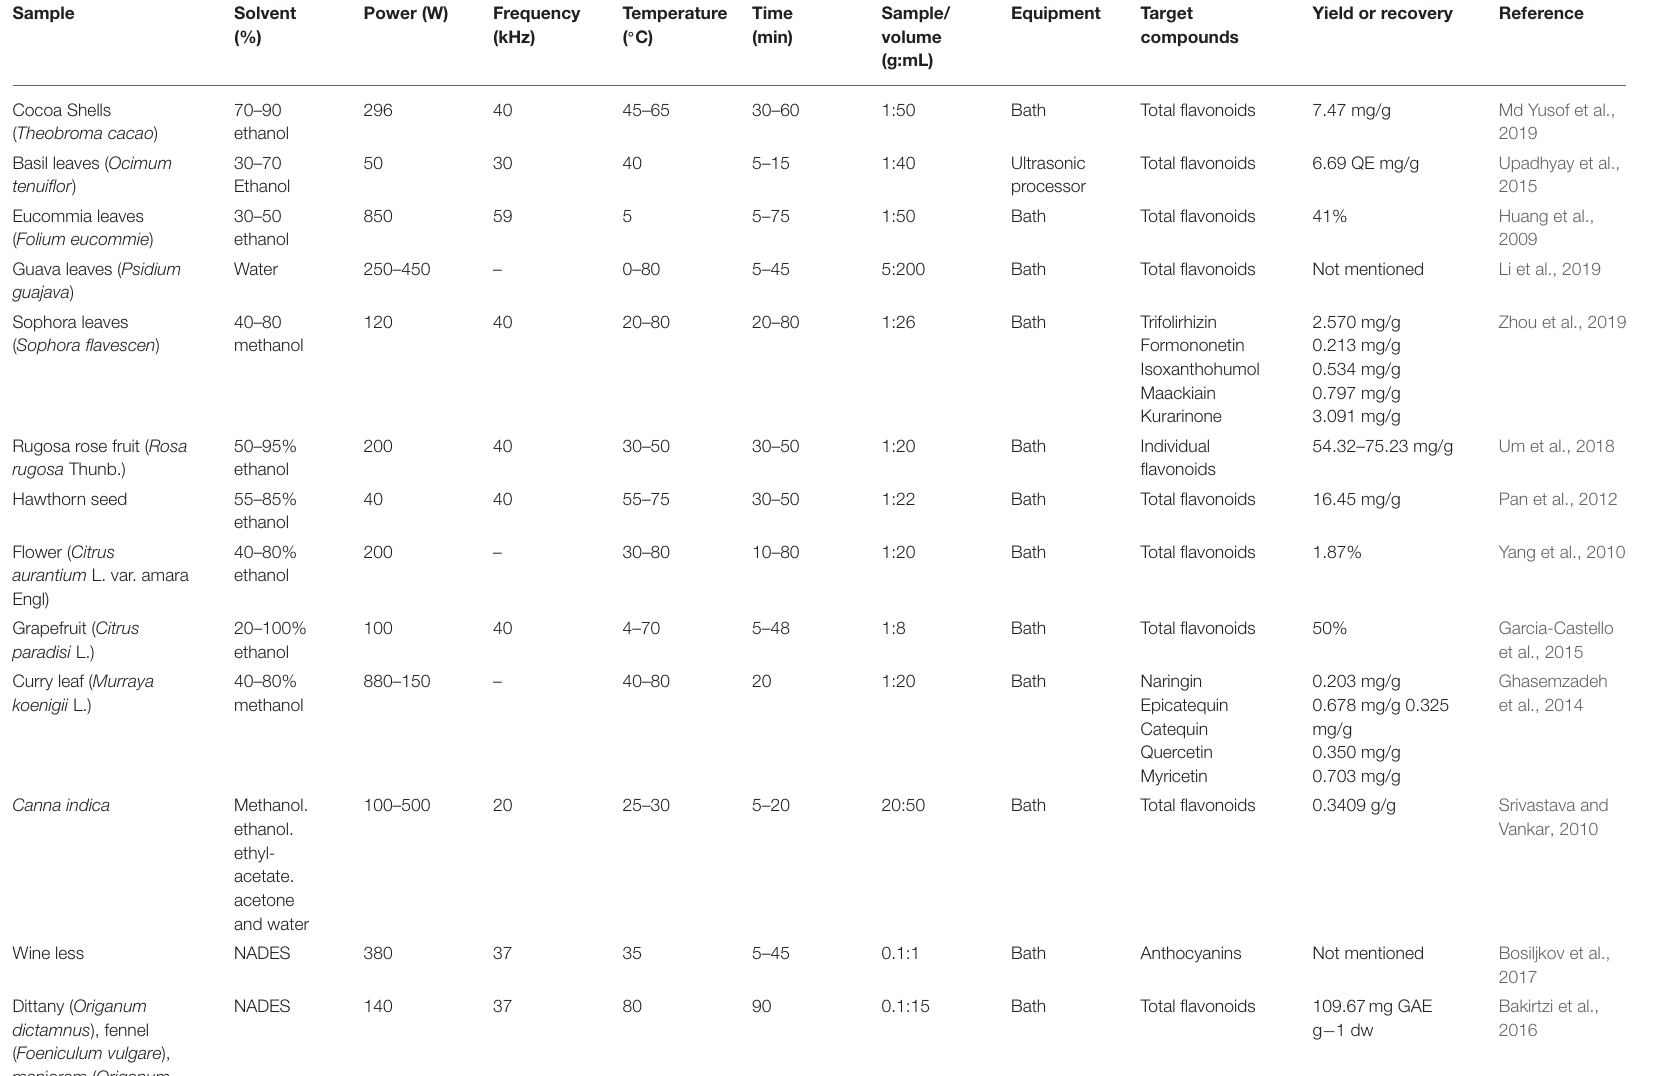
TABLE 2 | Experimental conditions used for extraction ultrasound flavonoids from natural products.